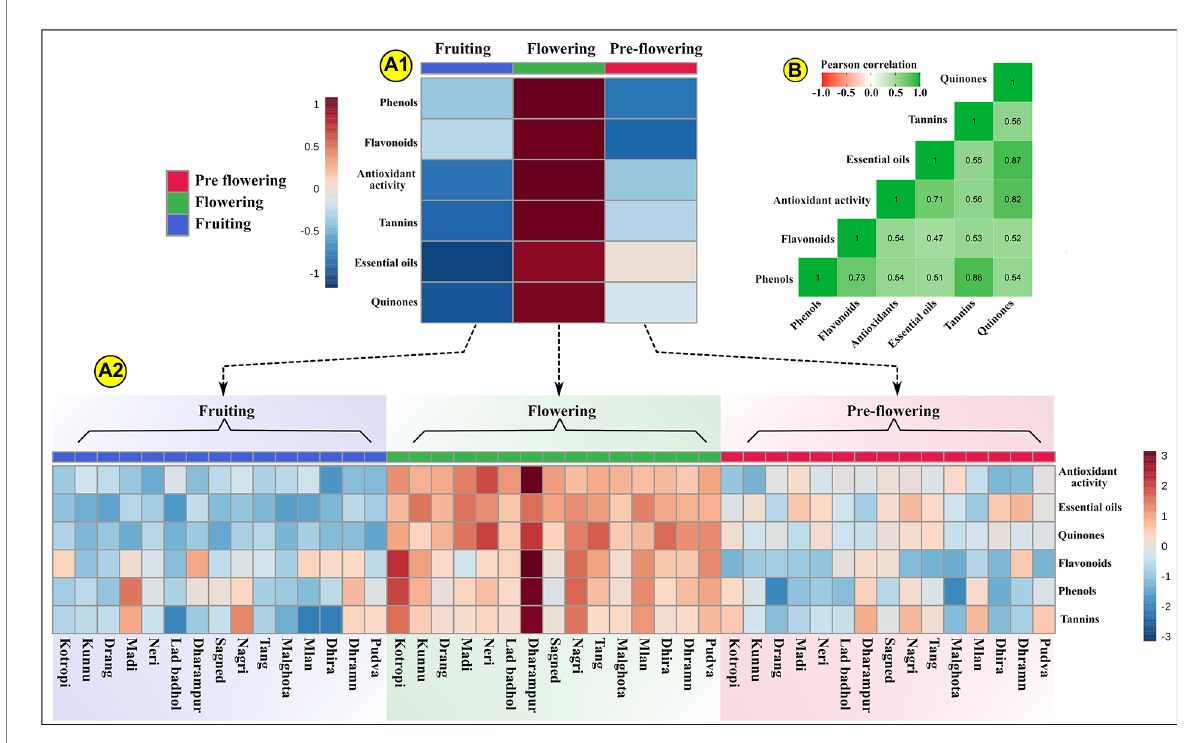
FIGURE 5 Represents the phytochemical composition of MK ( Murraya koenigii (L.) Spreng.) leaves through a heat map. (A1) Indicates the scaled mean phytochemical profile of MK leaves at three development stages. The data is scaled between +1 and –1. (A2) Represents the scaled photochemical profile of MK leaves for each sample at each of the three development stages. The data is scaled between +3 and − 3; (B) Indicates the Pearson’s r correlation values through a heat map. The Pearson’s r (+1 to − 1) is indicated through different color